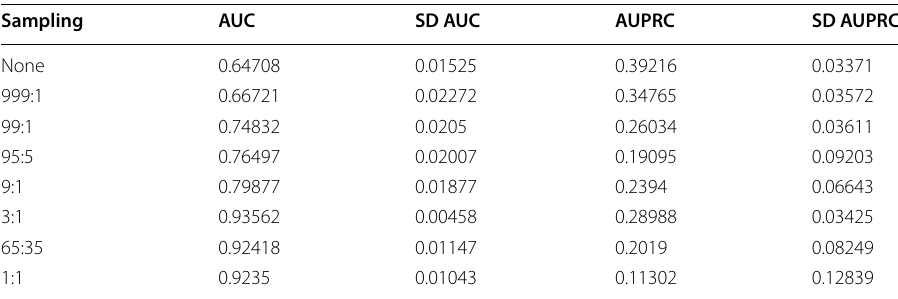
Table 13 Results for decision